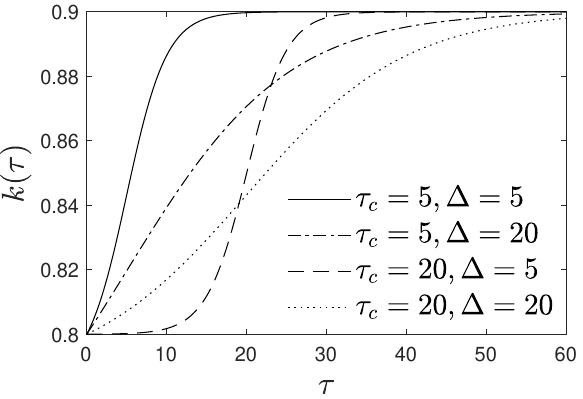
Figure 1. The ratio k ( τ ) (6) as a function of the reduced time τ (3) for the initial and final values k 0 = 0.8 and k 1 = 0.9, respectively, for different choices of the parameters τ c and ∆